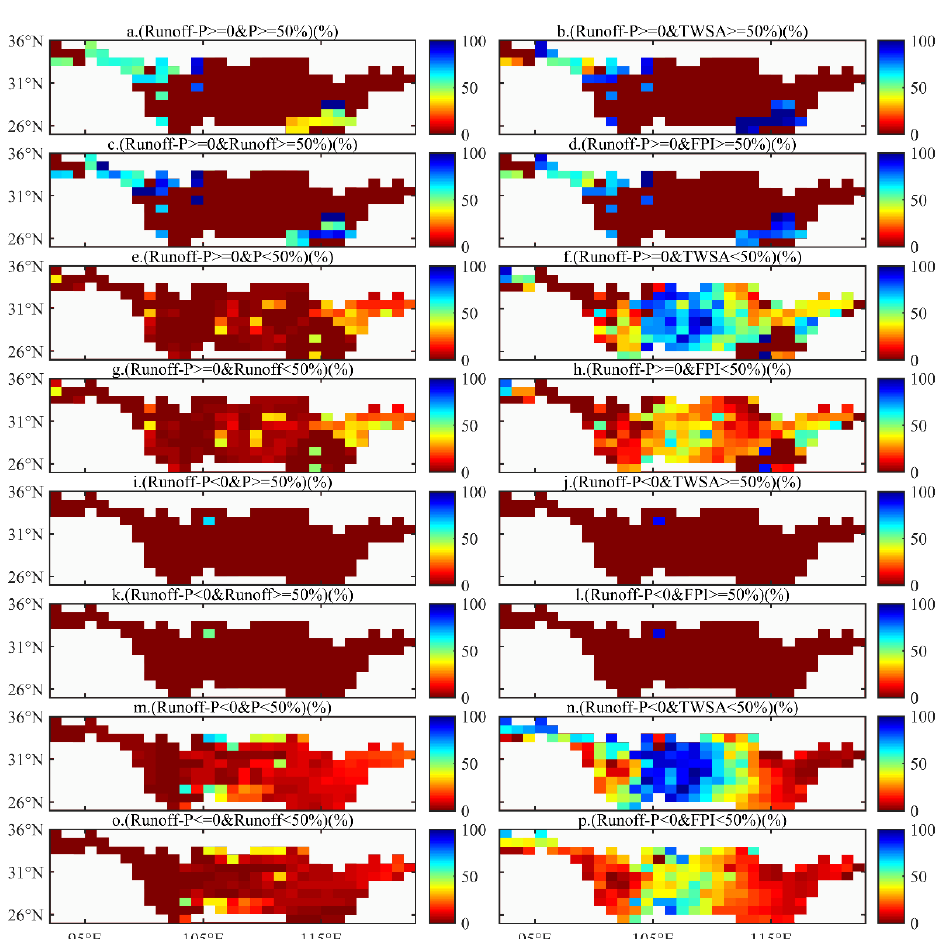
Figure 7. Different cases for the percentile of runoff, precipitation, FPI and TWSA compared to 50% for the positive and negative value of runoff minus precipitation in the YRB during April 2002–December 2019.